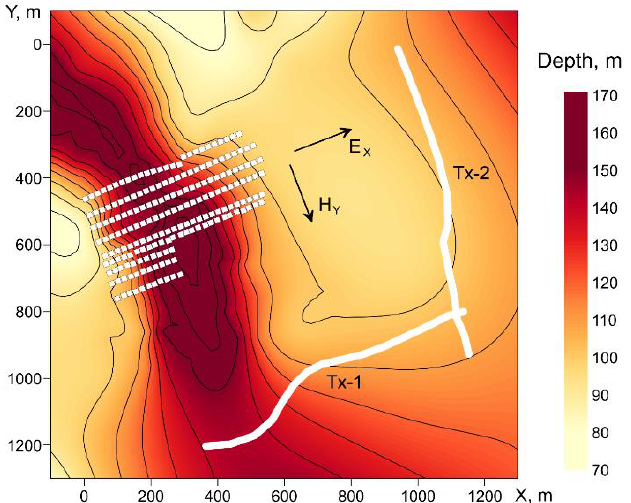
Figure 7. Topography of the top of the first layer of limestones. The white squares depict receiver stations. The white lines are grounded transmitters lines. Arrows Ex and Hy indicate orientation of the local coordinate axes at receiver stations. Coordinates of the acquisition system are attached to the electronic version of this article.